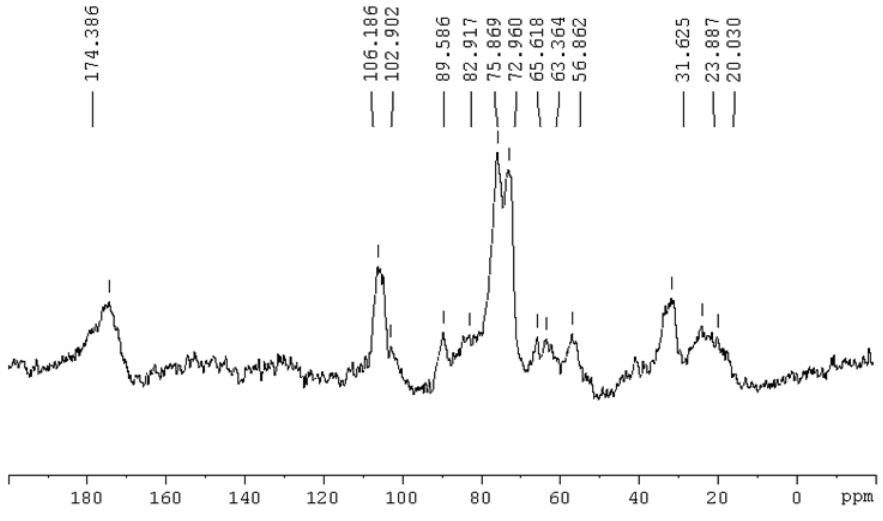
Figure 3. The 13 C-NMR spectra of raw